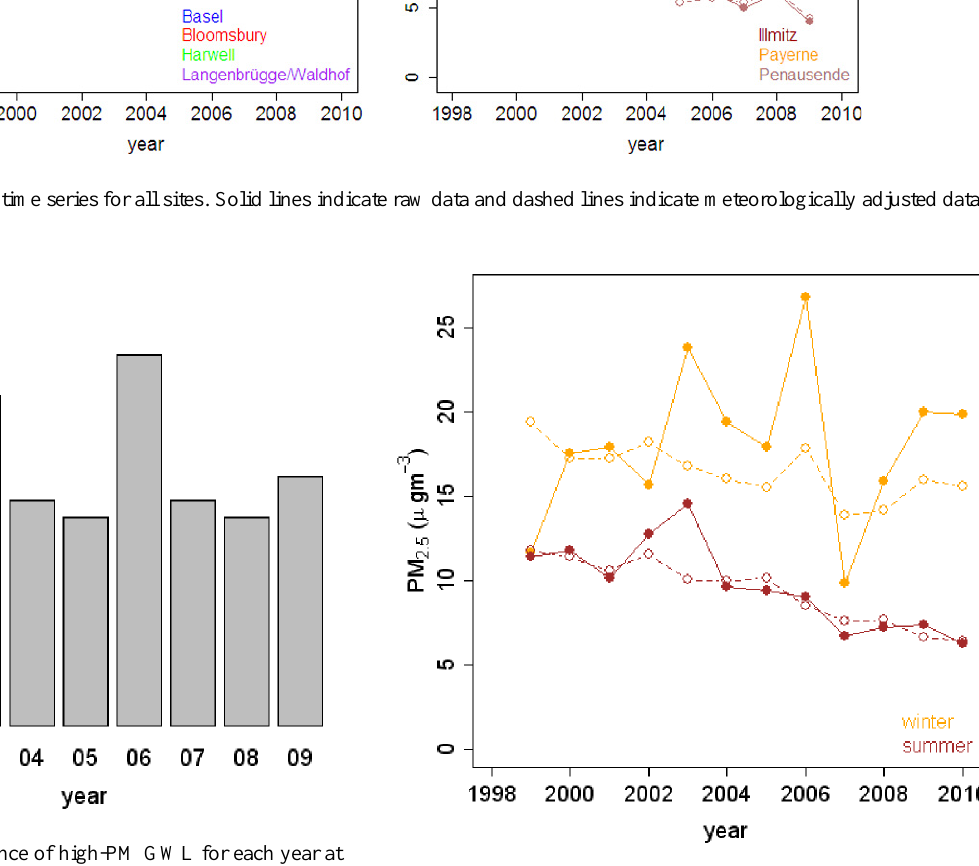
2 . 5 concentrations at Payerne for winter and summer data. Solid lines indicate raw data and dashed lines indicate meteorologically adjusted